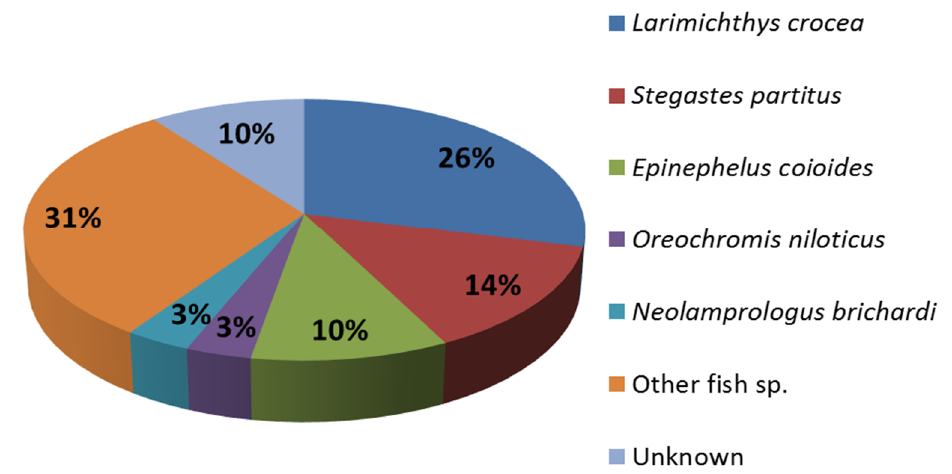
Figure 2. Annotation of differentially expressed genes using BLASTX [19] against the Genbank Non-Redundant database detailing the species distribution of annotations. The group ‘Other fish sp’ combined fish species that had only one hit in the data set.